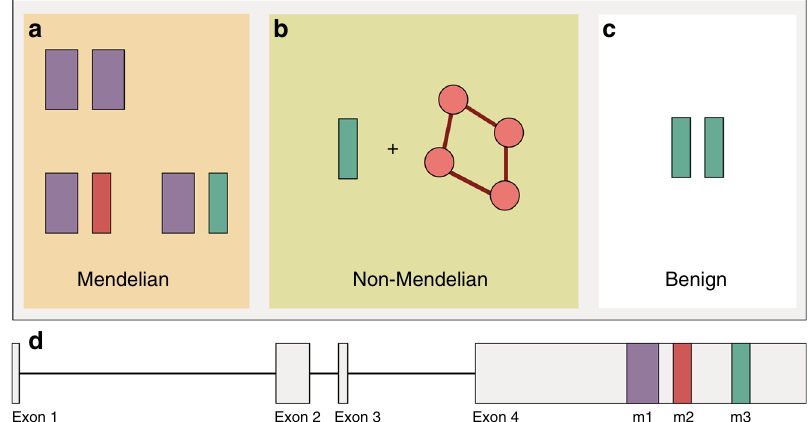
Fig. 3 Schematic representation of the inheritance pattern of the identi fi ed mutations in RP1 , highlighting the concept of rs118031911/T-mediated quasi- Mendelian inheritance of HRDs. a In trans with respect to the Alu element insertion (m1, or c.4052_4053ins328/p.Tyr1352Alafs*9), m3 (rs118031911/T, or c.5797C>T/p.Arg1933*) results in autosomal recessive inheritance of the disease, similar to m1 in a homozygous state or in a compound heterozygous combination with m2 (c.4196del/p.Cys1399Leufs*5). b Combinations of the hypomorphic m3 allele with additional hypomorphs and/or heterozygous recessive alleles in other genes result in disease following a non-Mendelian pattern, whereas ( c ) homozygosis for m3 has no pathological consequences. d Structure of RP1 : exons are represented by boxes, connected by solid lines (introns). The relative positions of m1, m2, and m3 are also